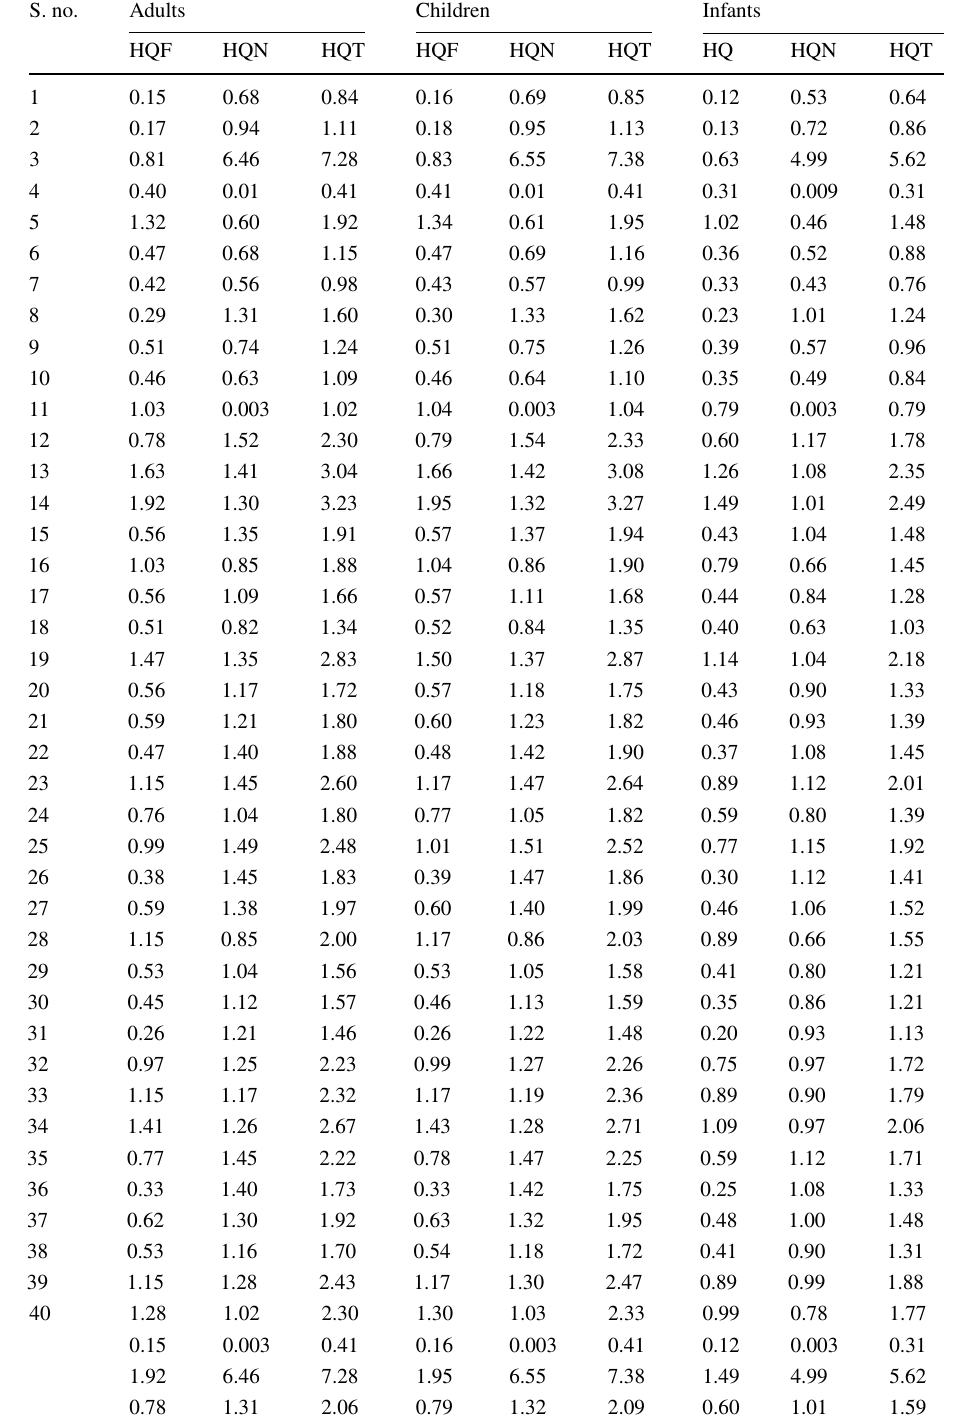
Table 7 Computation of hazard S. no. Adults Children quotient for adults, children, and infants